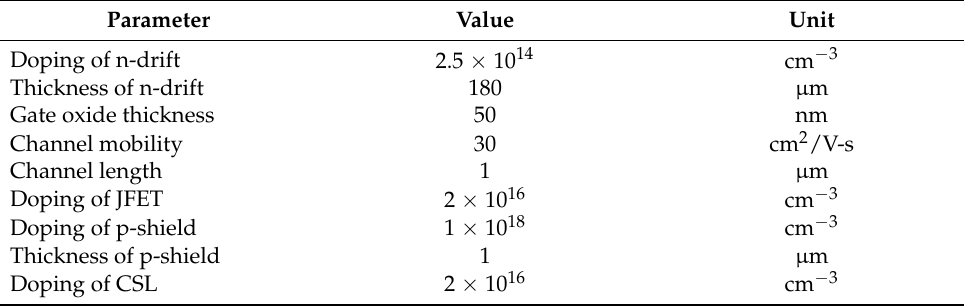
Table 1. Parameters of the studied IGBTs.